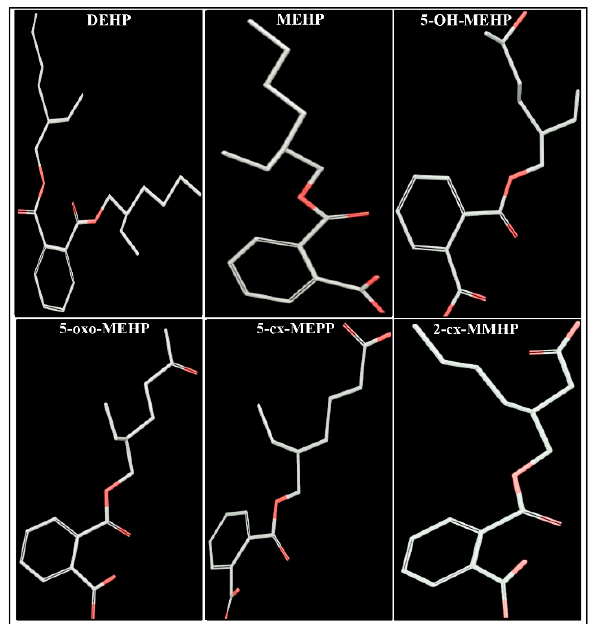
Figure 1. Three-dimensional representation of di-(2-ethylhexyl) phthalate (DEHP) and its five major metabolites, mono-(2-ethylhexyl)phthalate (MEHP), mono-(2-ethyl-5-hydroxyhexyl) phthalate (5-OH-MEHP), mono-(2-ethyl-5-oxohexyl)phthalate (5-oxo-MEHP), mono-(2-ethyl-5-carboxypentyl) phthalate (5-cx-MEPP), and mono-[2-(carboxymethyl)hexyl]phthalate (2-cx-MMHP).